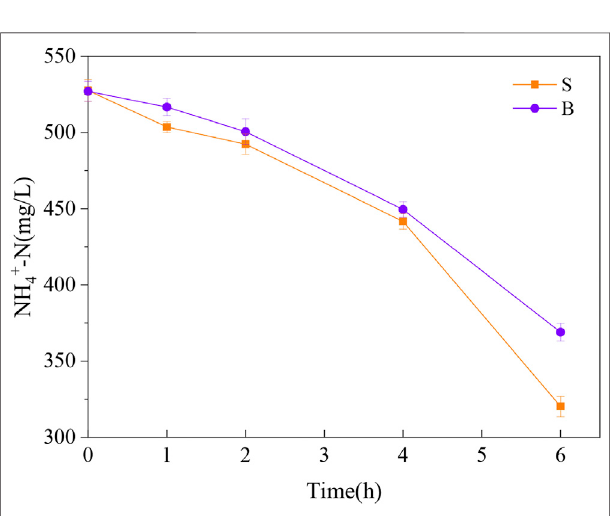
FIGURE 2 | Ammonia conversion rate in S and B